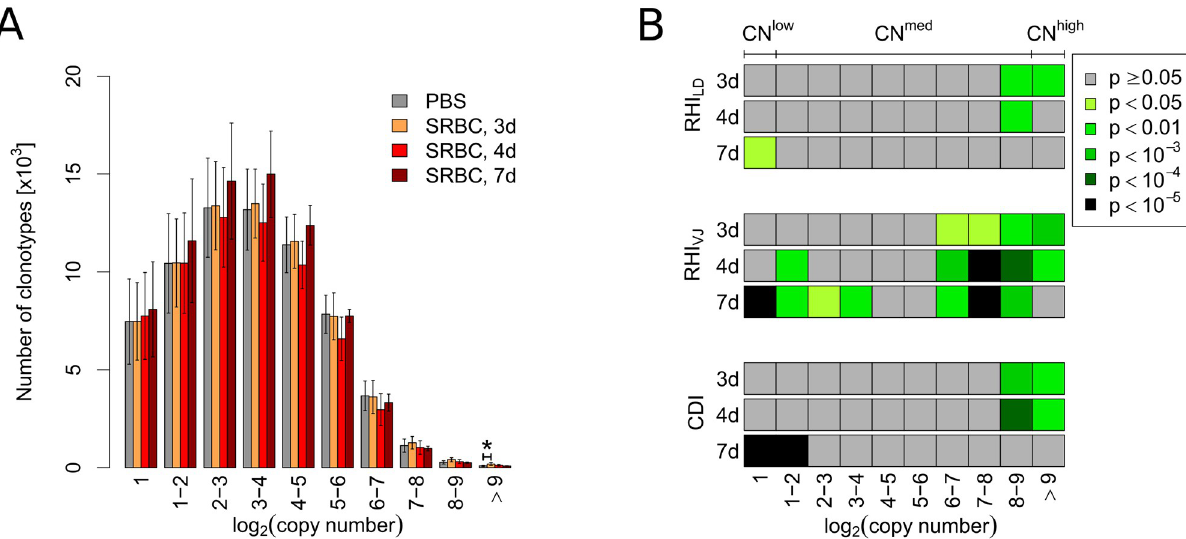
Fig 2. Logarithmic partitioning leads to repertoire fractions of appropriate size for separate analyses that reveal true extent and separation of two immunization-induced effects within the repertoire. Total repertoires where split into 10 fractions according to their copy number based on the logarithm to base 2. (A) Number of extracted clonotypes per fraction. Bars and whiskers display means and standard deviations. Repertoires of animals 3, 4 and 7 days (d) after immunization with SRBC (n = 10 each) were tested for deviations from the control (PBS-injected) repertoires (n = 20) using the Mann-Whitney-U-test. p -values are displayed as � p < 0.05. Correction for multiple testing was performed using Holm’s method. (B) For each fraction and time point immunized samples were compared to control samples for three parameters: the Repertoire Homogeneity Index (RHI) assessing repertoire homogeneity concerning either i) CDR3 β sequence similarity measured by the Levenshtein distance (RHI LD ) or ii) VJ segment usage (RHI VJ ) as well as iii) the Coding Diversity Index (CDI) assessing heterogeneity of clonotype coding. p -values refer to a one tailed Mann-Whitney-U-test with significant decrease of the respective index. The 10 p -values of each row were independently corrected for multiple testing using Holm’s method.